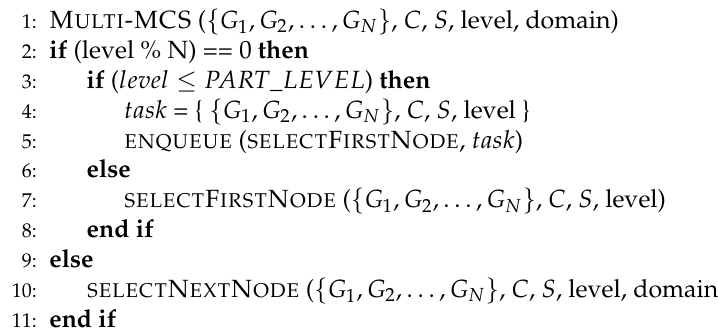
Algorithm 2 The parallel many-core CPU-based Multi-MCS Function: A unique recursive function that, given N graphs { G 1 , G 2 , . . . , G N } , computes MCS { G 1 , G 2 , . . . , G N } running several